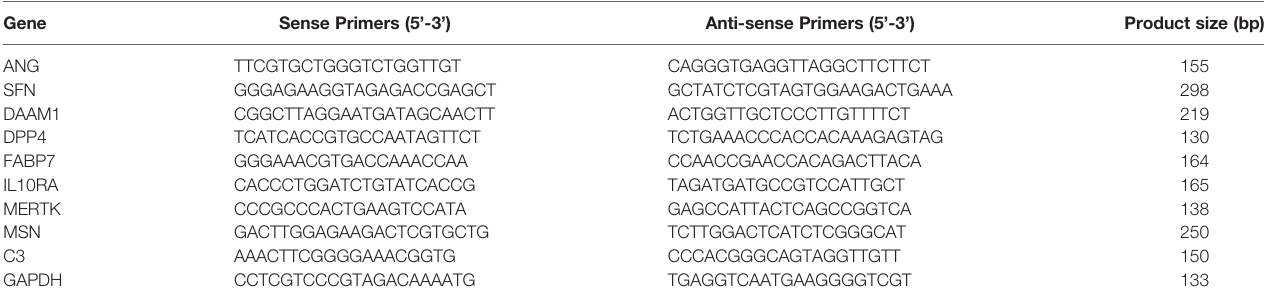
TABLE 1 | Primers and expected sizes of PCR products of target